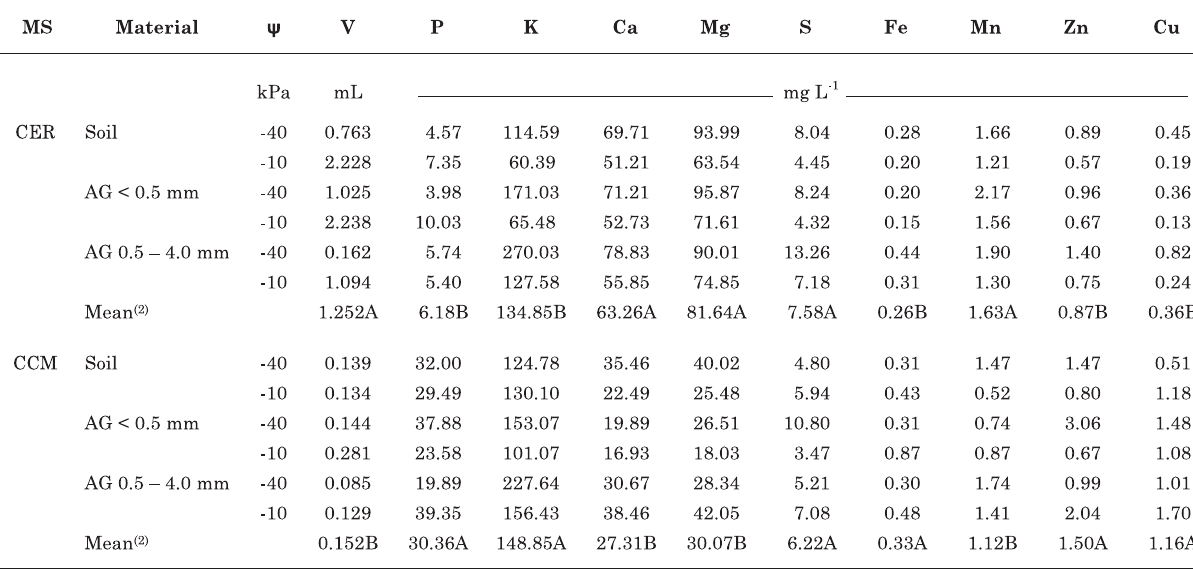
Table 5. Volume (V) and mineral composition of the xylem exudate, considering the material used for